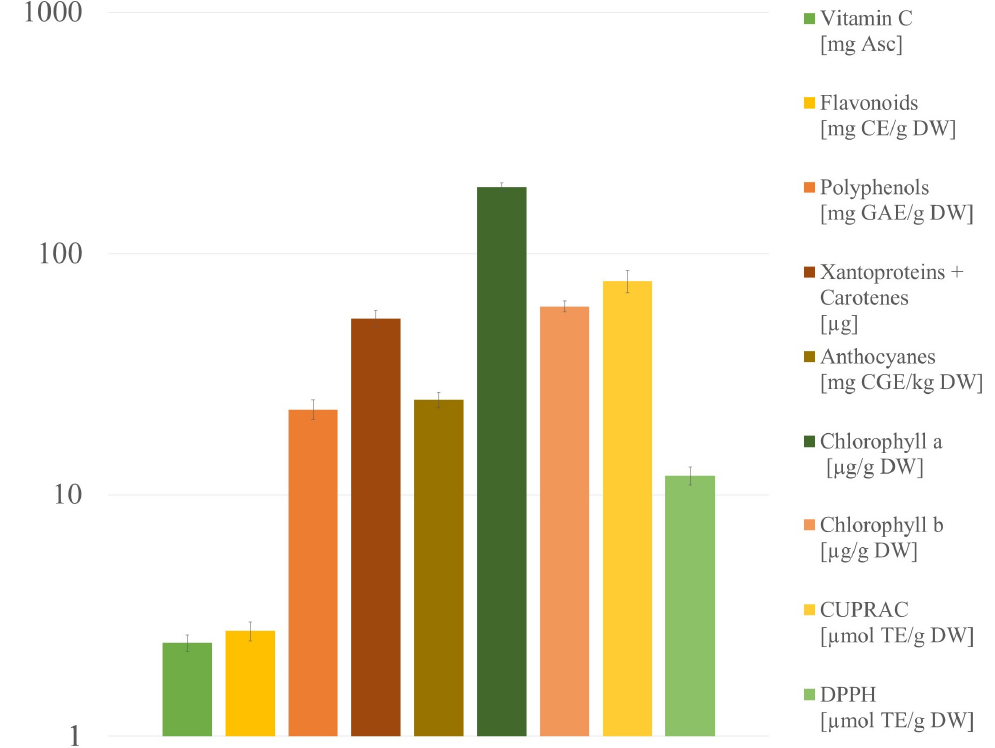
Figure 6. Bioactive compounds and antioxidant potential of kaffir lime peel.